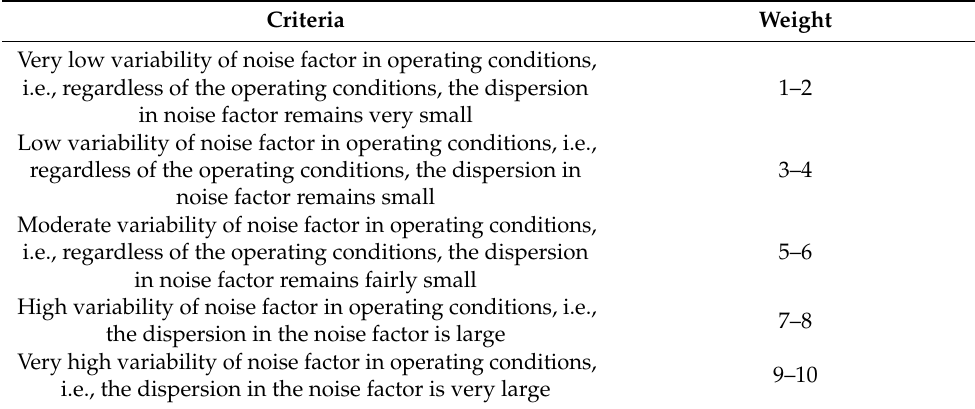
Table 4. Criteria for assessing the variability of noise factors [32]. Criteria Weight